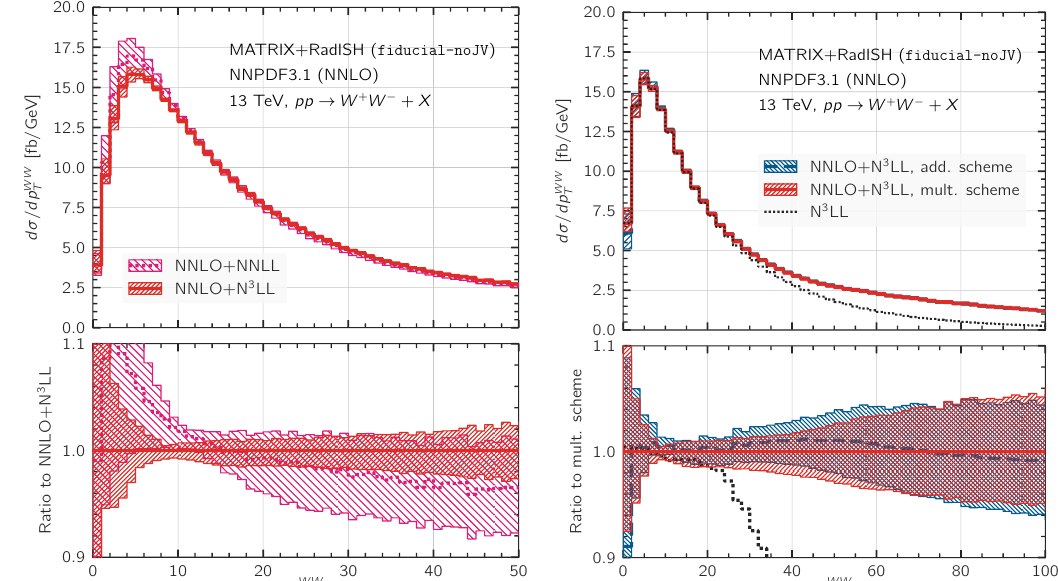
Figure 6 . Left plot: transverse-momentum spectrum of the W + W − pair in the fiducial-noJV phase space comparing predictions at NNLO+NNLL (magenta, dotted) and NNLO+N 3 LL (red, solid) accuracy. The lower frame shows the ratios of the predictions to the central value of the NNLO+N 3 LL result. Right plot: same distribution comparing additive (dark blue, dashed) and multiplicative (red, solid) matching schemes at NNLO+N 3 LL. The lower frame shows the ratios of the predictions to the central value of the multiplicative